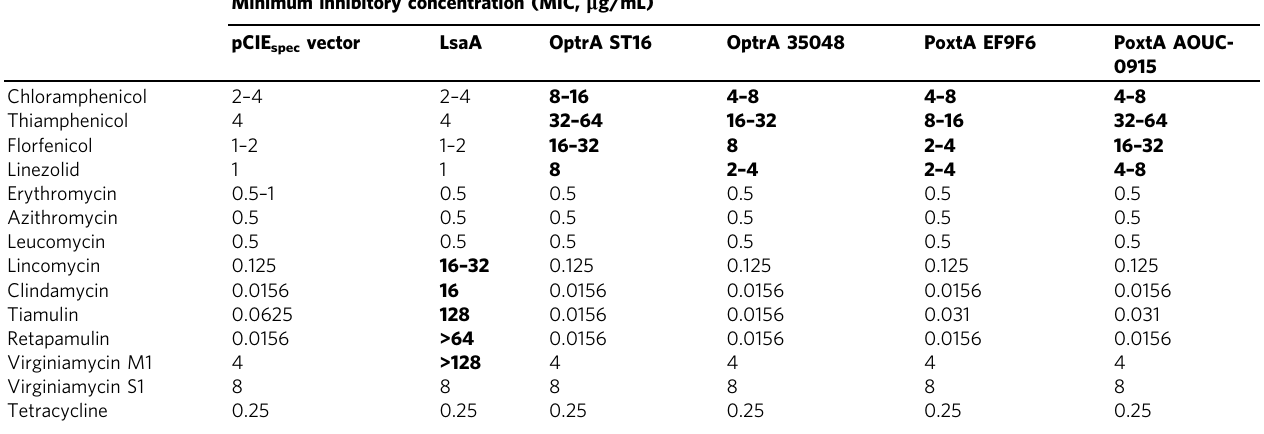
Table 1 Antibiotic-resistance spectra of LsaA, OptrA and PoxtA ARE –